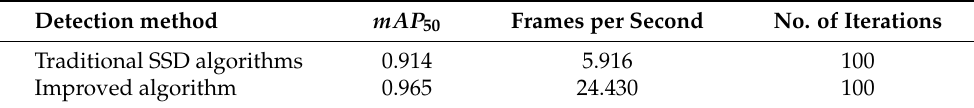
Table 1. Improved and traditional SSD algorithm comparison test results.